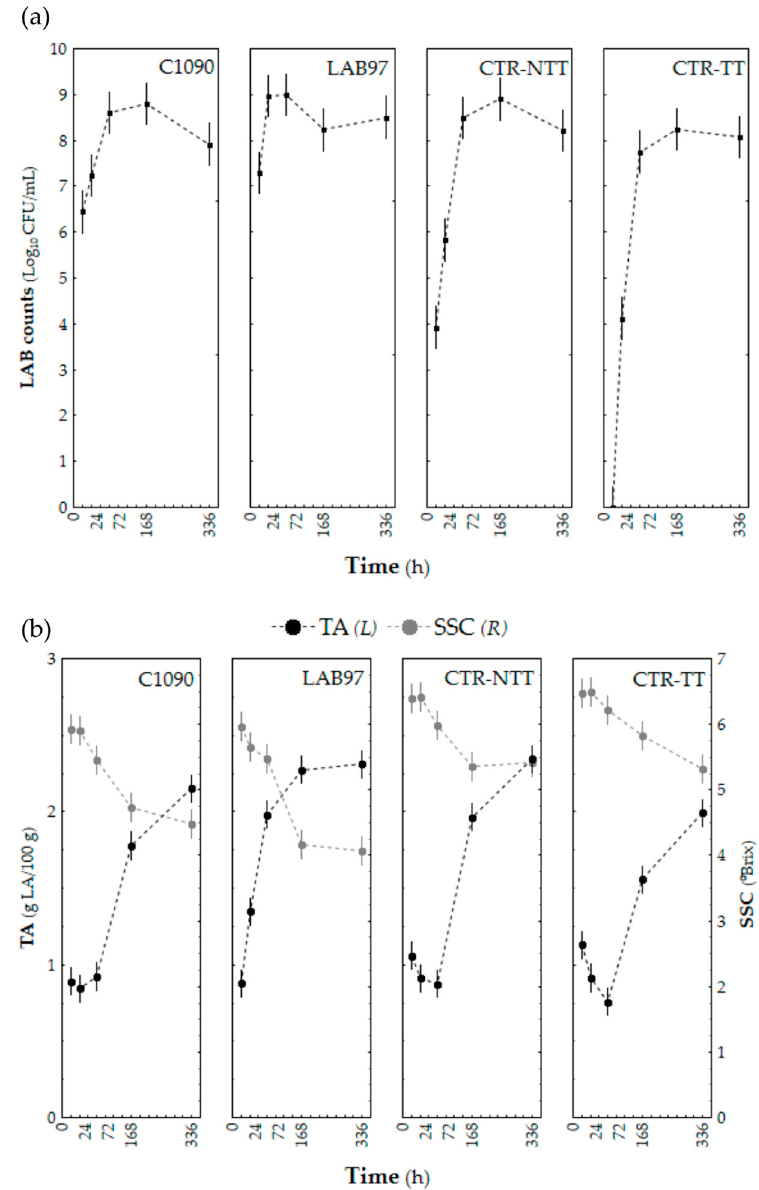
Figure 2. The LAB counts (log 10 CFU/mL), ( a ) TA (g LA/100 g FW), and SSC (°Brix) ( b ) evolution throughout the lactic acid fermentation of immature tomato pulp samples that were inoculated with single LAB starter cultures (LAB97 and C1090) and non-inoculated samples (CTR-NTT and CTR-TT) for 14 days. Bars represent the confidence intervals at 95%.